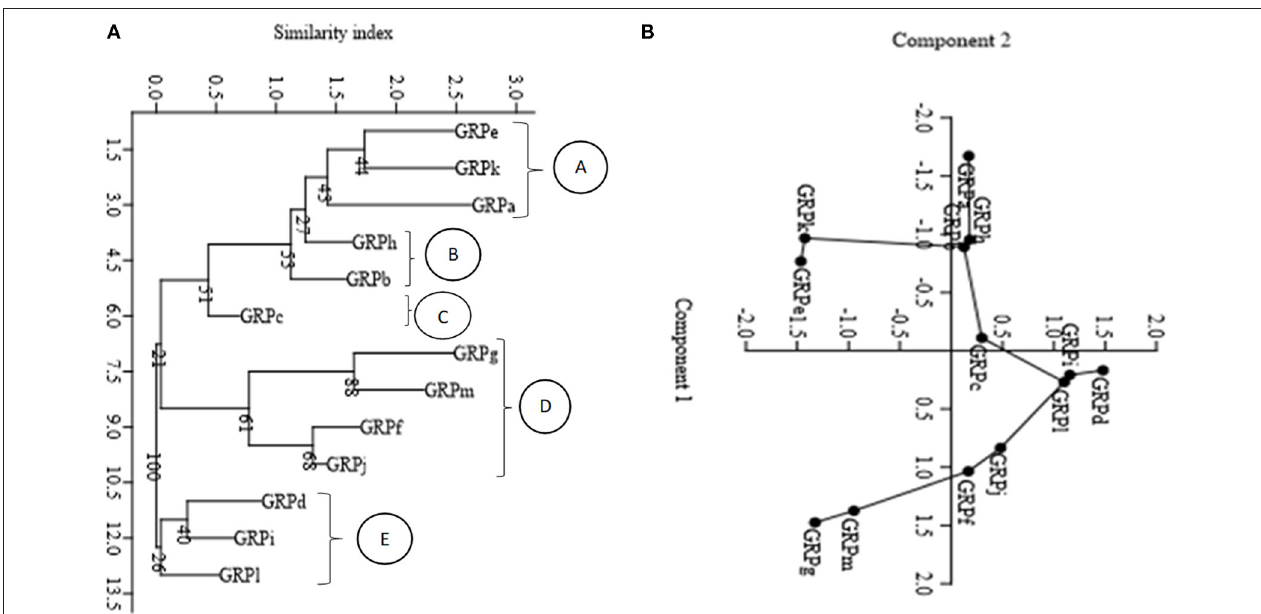
FIGURE 1 | Distance dendrogram and principal component analysis diagram displaying morphological distribution of the nodule isolates. (A) Neighbor joining dendrogram based on Euclidian similarity index; (B) Principal component analysis (PCA) (Variance and Eigen values in the first two components; 1st component variance = 59.32%, Eigen value = 3.59 and 2nd component variance = 21.21%, Eigen value 1.28). The numbers displayed at the nodes of figure (A) (dendrogram) indicate the bootstrap support values in percentage after 1,000 resampling.